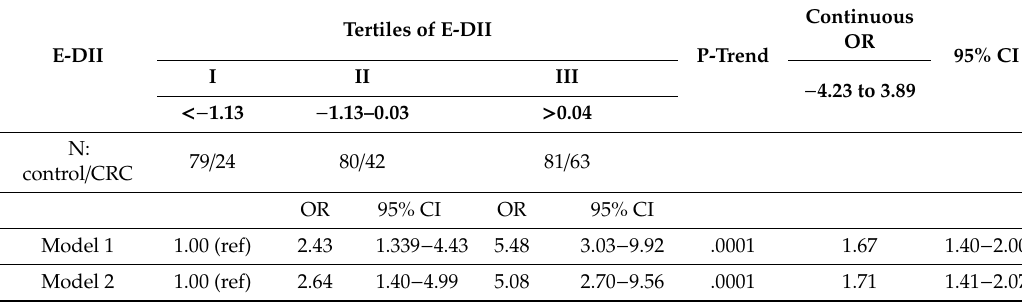
Table 3. Odds ratios and 95% confidence intervals for the association between energy-adjusted DII (E-DII) and CRC, Iranian CRC and CAP case-control Study, Tehran, 2017–2018. Tertiles of E-DII E-DII